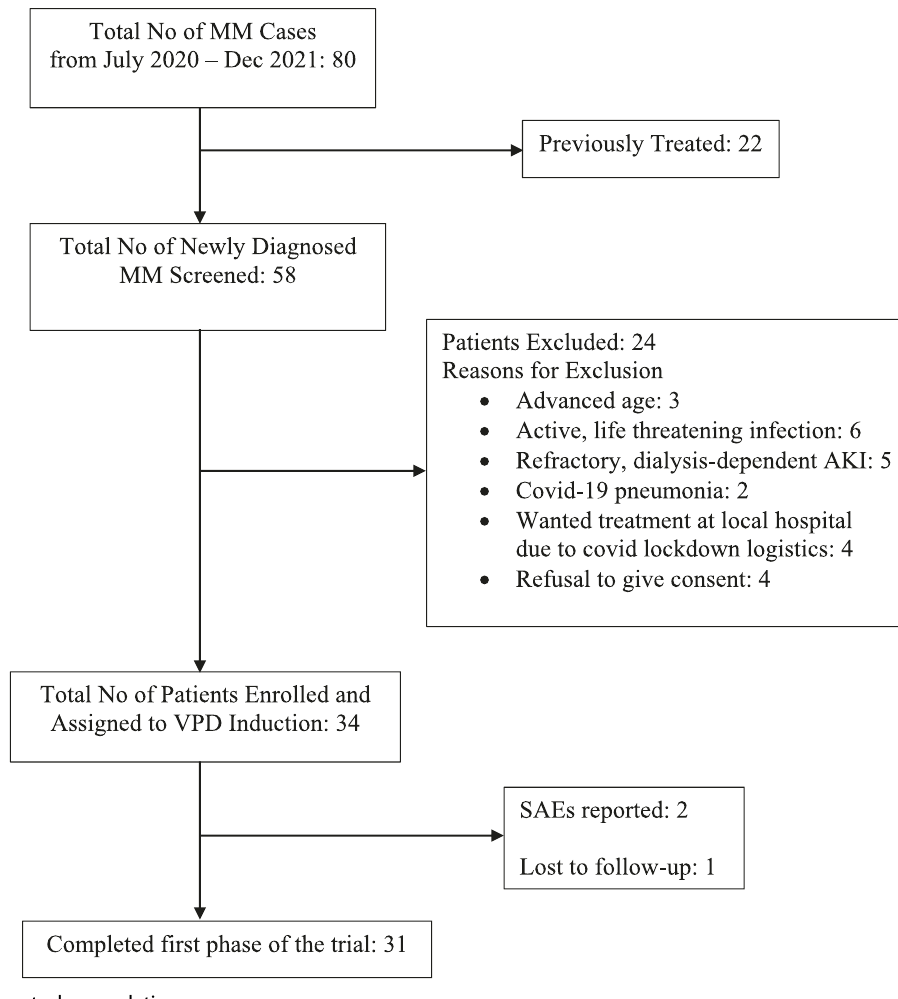
Fig. 1 Consort of the study